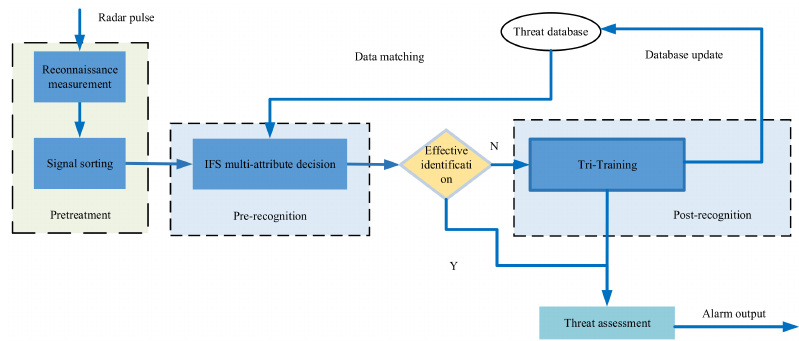
Figure 2. Hierarchical processing mechanism identification